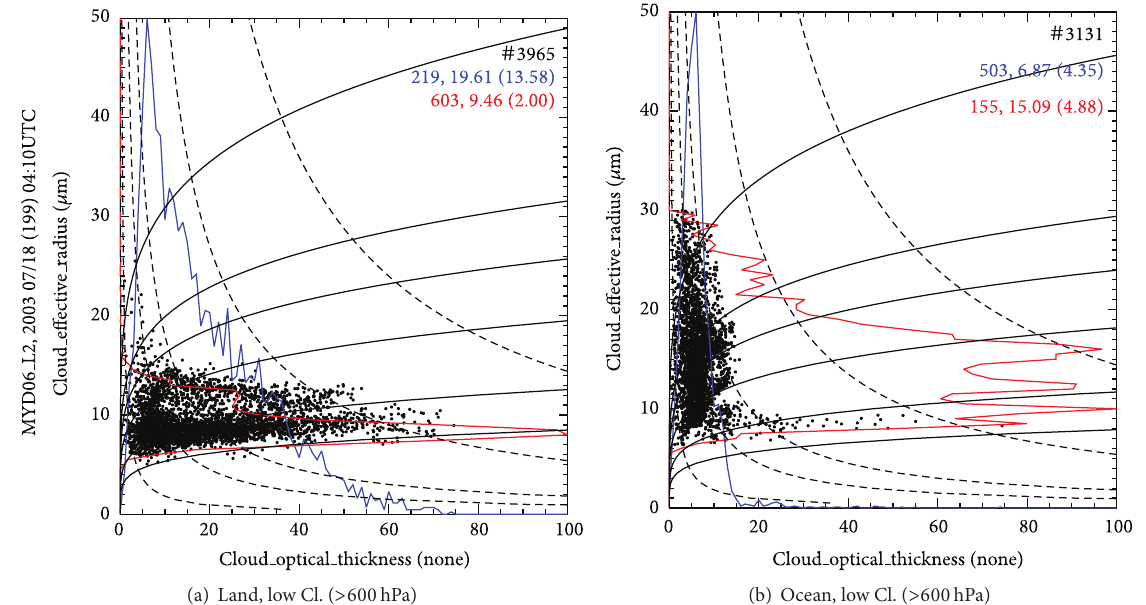
Figure 15: Scatter plots of optical thickness ( 𝜏 ) and effective radius ( 𝑟 𝑒 ) of lower-level cloud over land (a) and ocean (b) in the analysis area at 0410 UTC July 19, 2003. The blue (red) line represents a normalized histogram of 𝜏 ( 𝑟 𝑒 ). The values in the panels represent the numbers of observations, the maximum values in the histograms, and the averages and standard deviations of 𝜏 (blue) and 𝑟 𝑒 (red). The solid lines show the cloud droplet number concentration (from top to bottom): 10, 30, 50, 100, 300, and 800 [cm −3 ], and the dashed lines show the liquid water path (from bottom to top): 10, 50, 100, 300, and 800 [gm −2 ] calculated using (12) and (13) of [23],